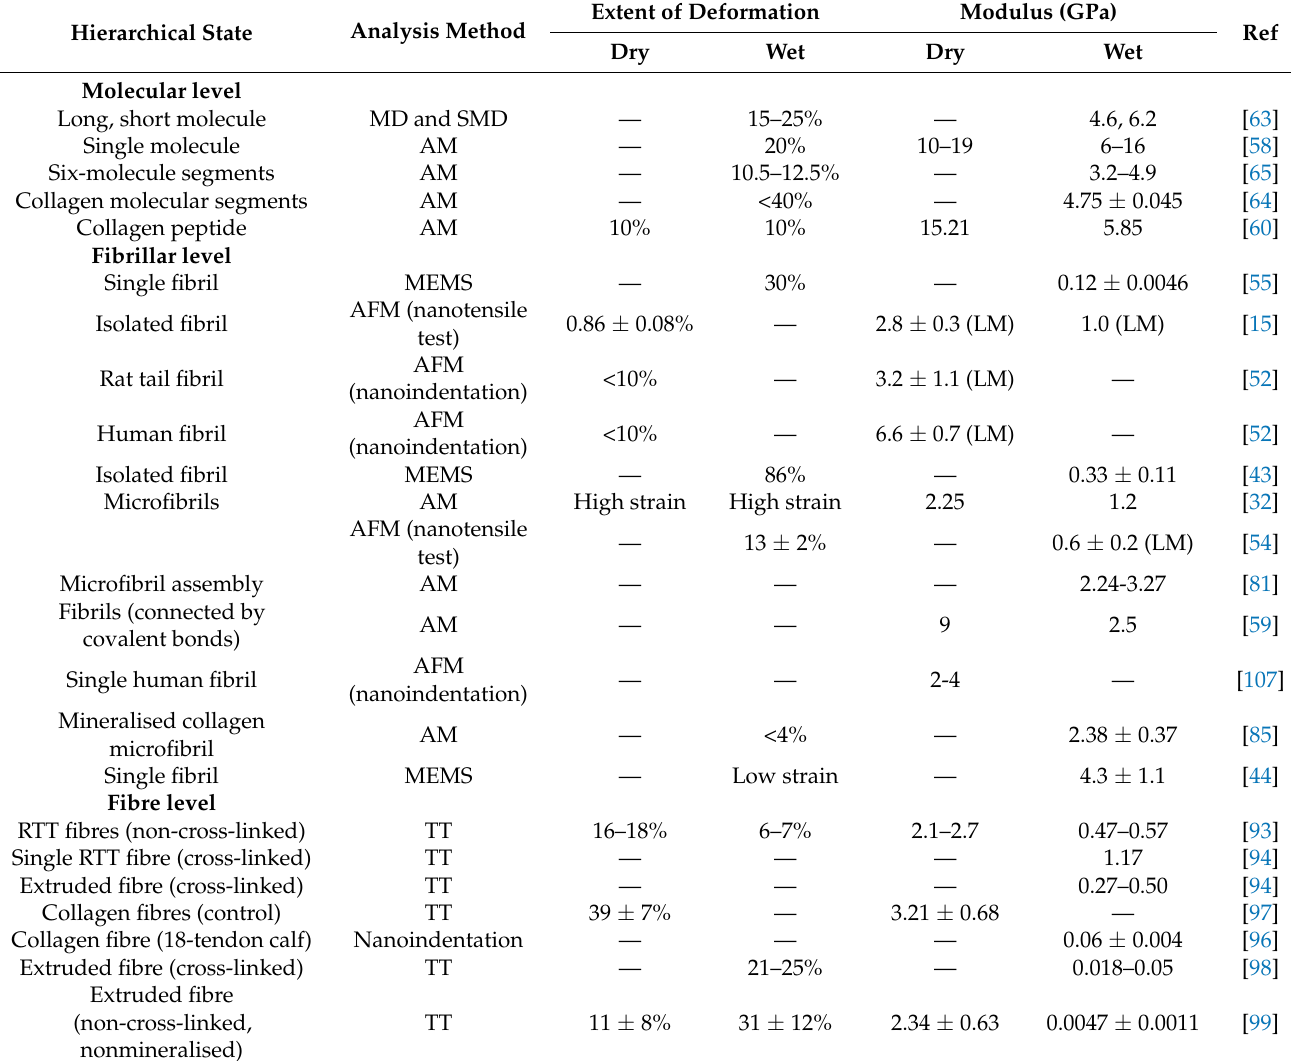
Table 1. Extent of deformation and modulus for dry and wet collagen at all hierarchy